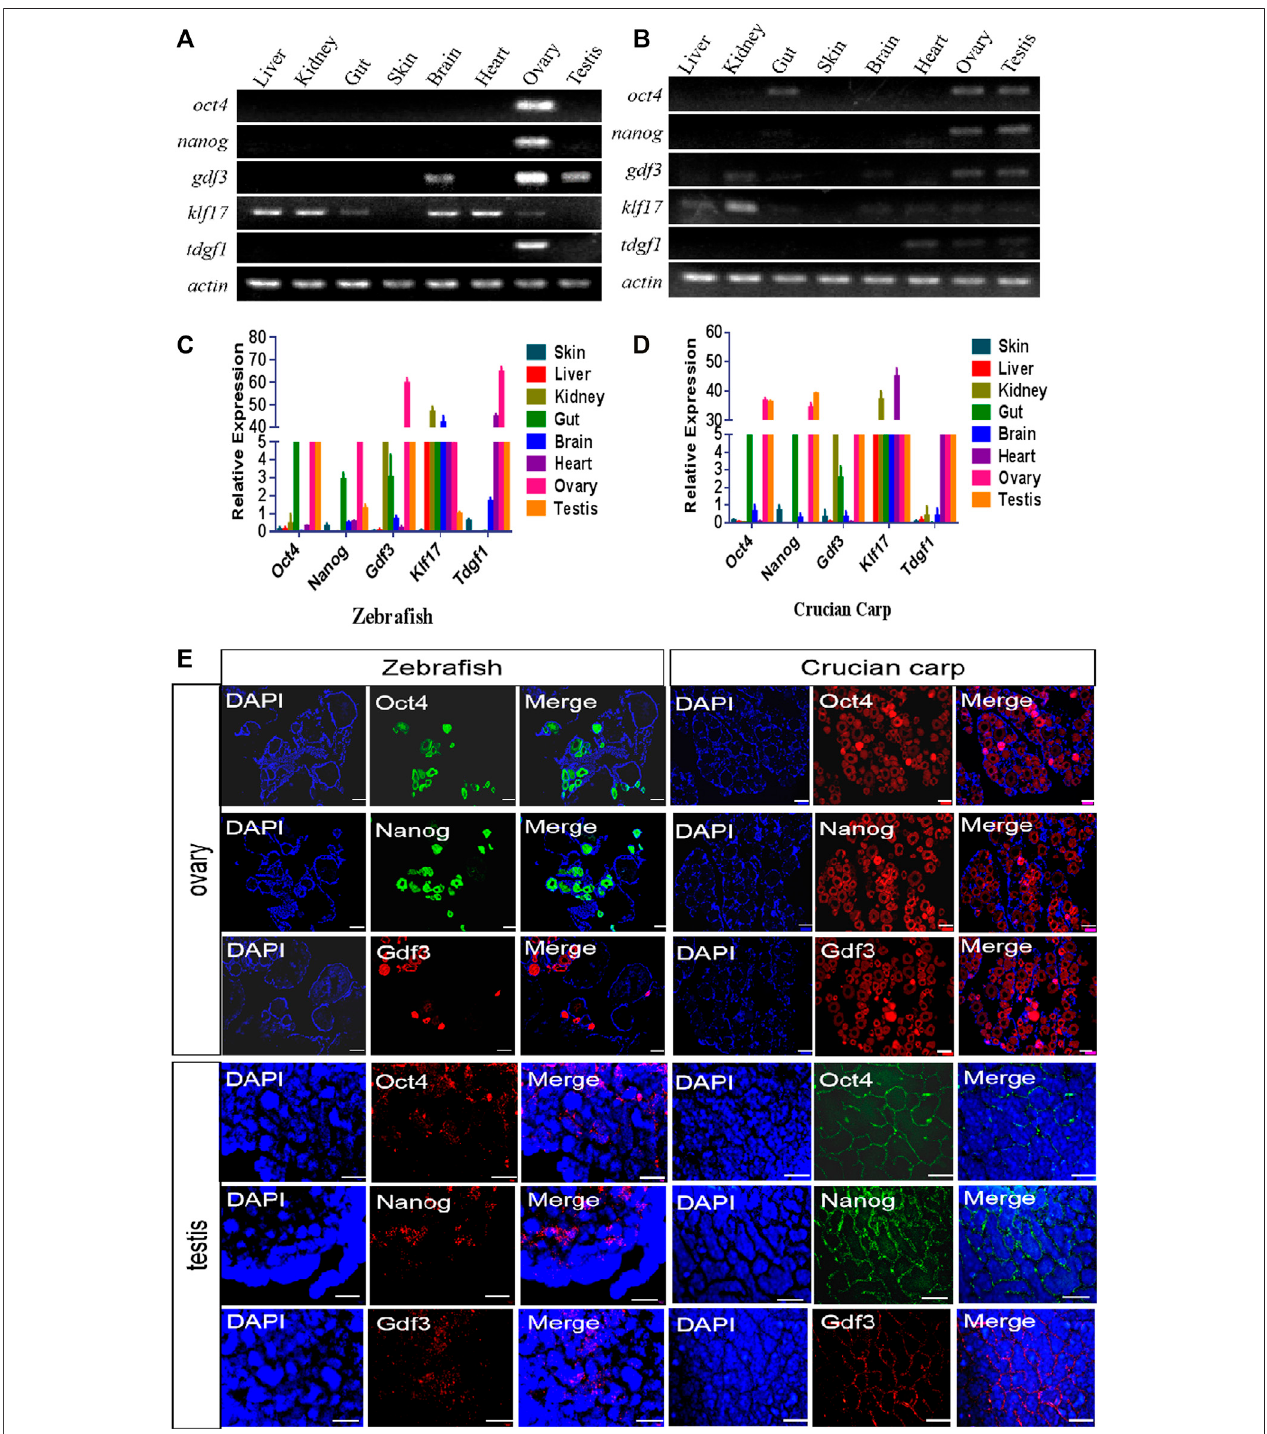
FIGURE2 | Expression patternofcandidate pluripotent genesin adult tissues. (A,B) RT-PCR analysisof the expression of fi ve pluripotent genes in eight tissuesof zebra fi sh (A) and crucian carp (B) . It was clearly showed that all of these genes were no expressed in skin tissue, but mainly expressed in ovary and testis, and some genessuchas Klf17 werewidelyexpressedinthemostoftissues. (C,D) qRT-PCRanalysisoftheexpressionof fi vepluripotentgenesineighttissuesofzebra fi sh (C) and crucian carp (D) . The results showed that the expression patterns of these genes in different tissues of zebra fi sh and crucian carp were similar. Oct4, Nanog and